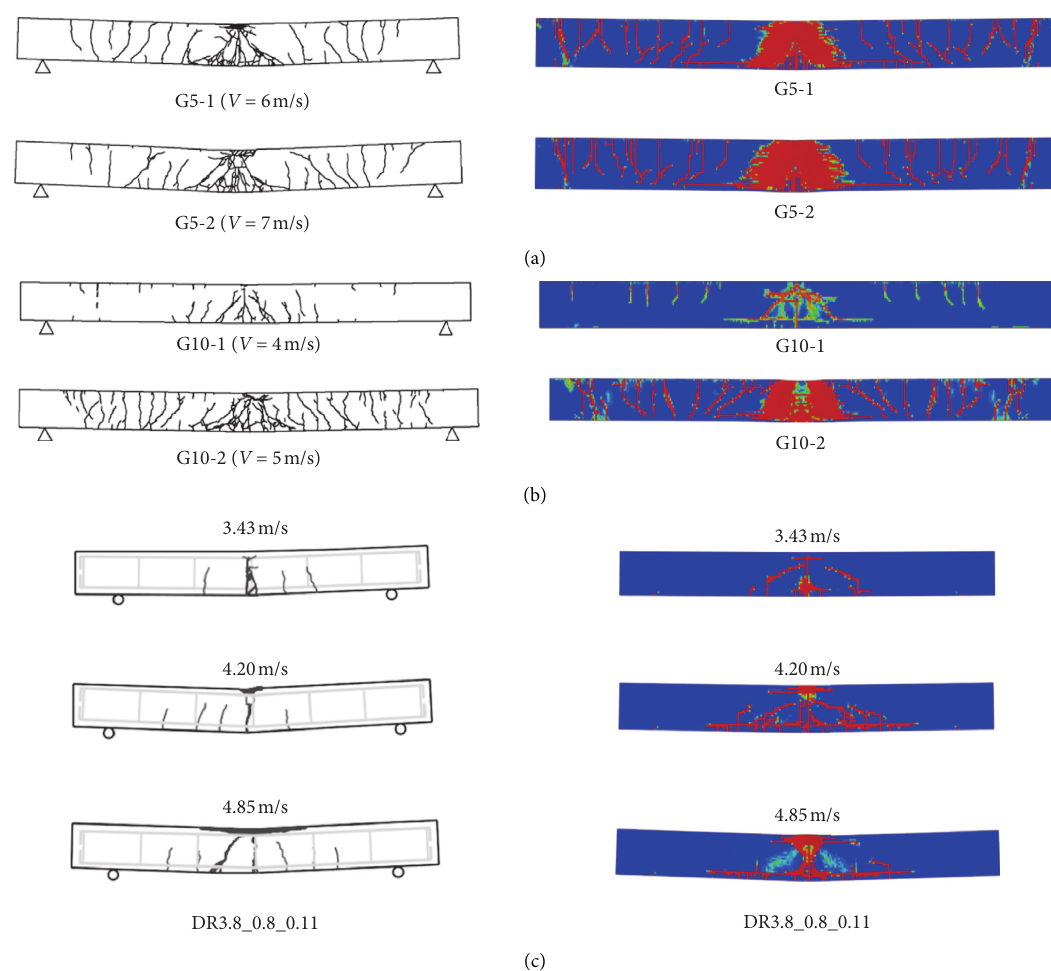
Figure 10: Comparison of the damage pattern for RC beams between the simulation and experiments. (a) Kishi’s experiment series G5. (b) Kishi’s experiment series G10. (c) Adhikary et al.’s